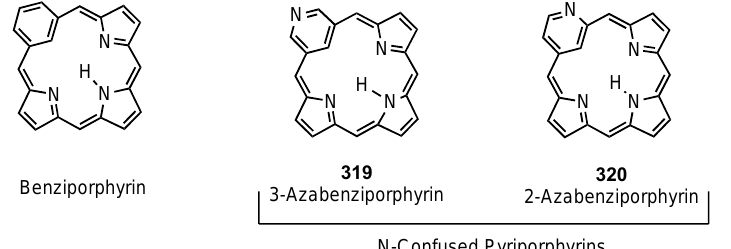
Figure 7. N-Confused Pyriporphyrins.